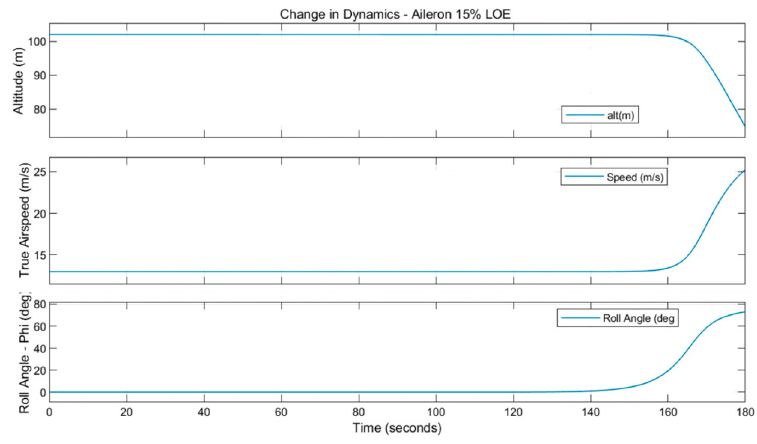
Figure 13. Change in dynamics for the aileron 15% LOE fault.